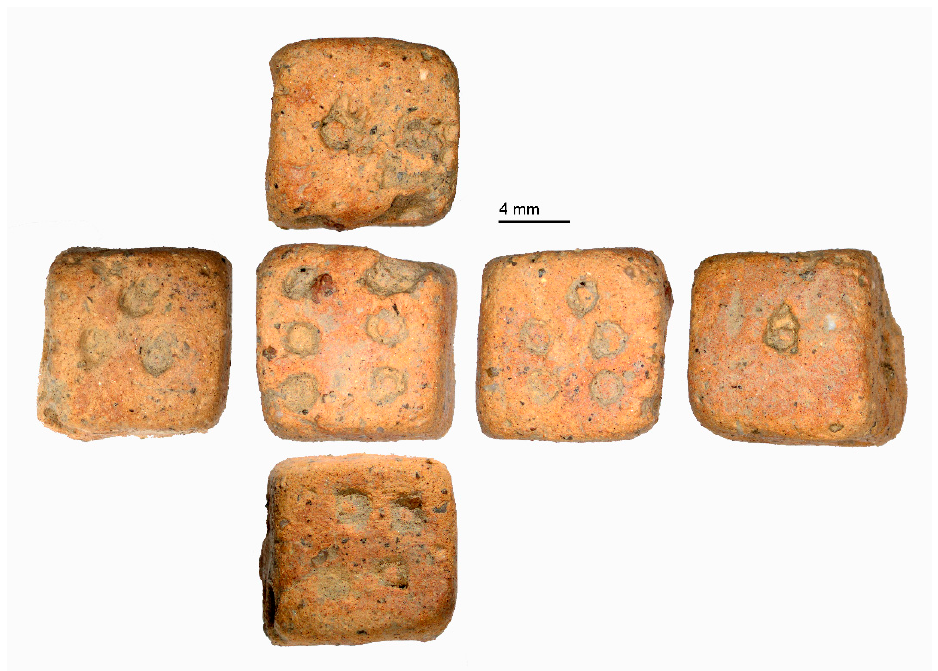
Figure 7. The dice VF14.SP386D 9 from Villa del Foro, with numbers 1–6 incised in the 1-6 2-4 3-5 configuration. Scale bar: 4